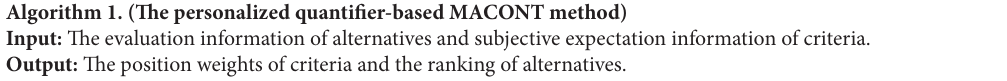
Algorithm 1. (The personalized quantifier-based MACONT